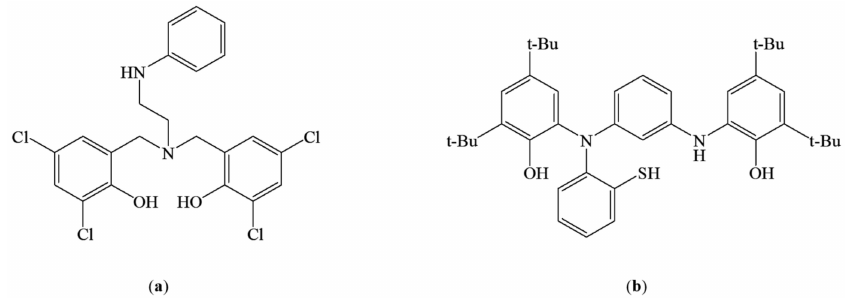
Figure 13. L127 ( a ) and L128 ( b